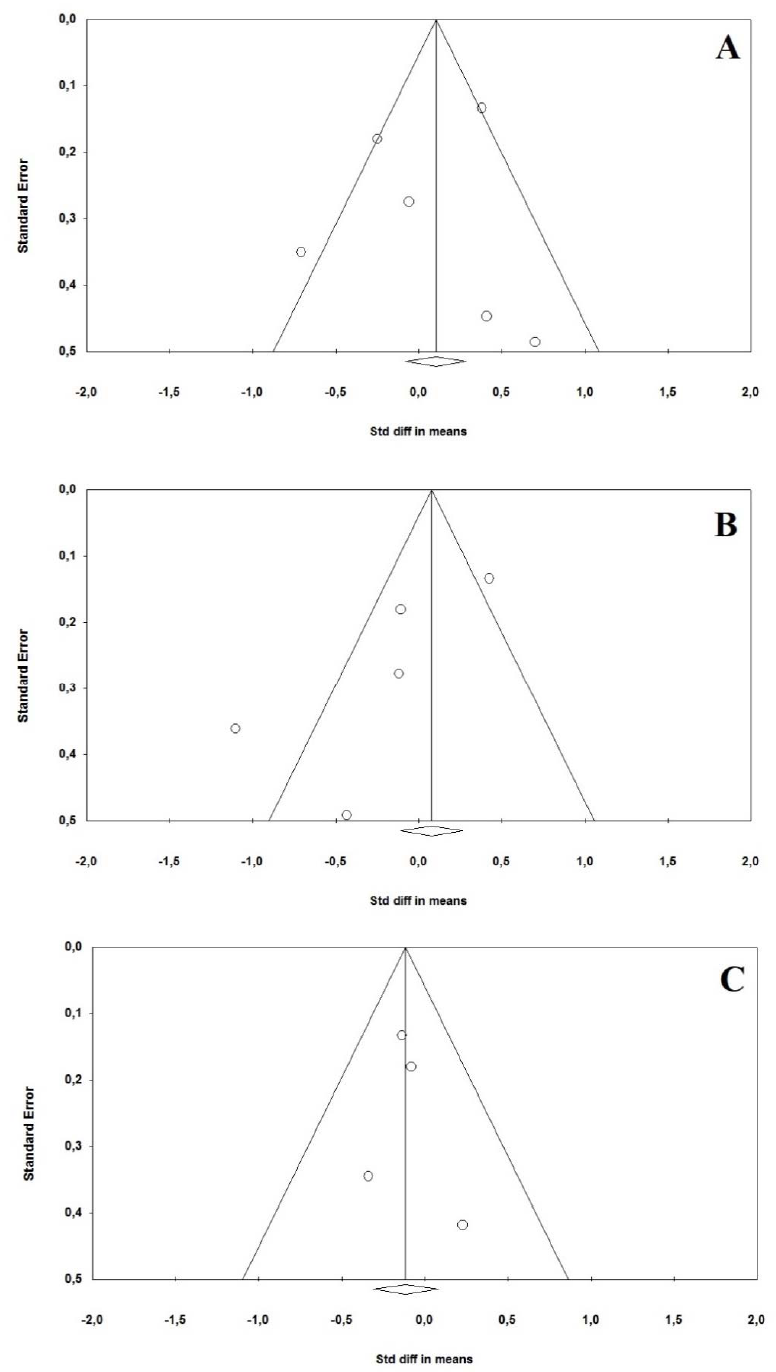
Figure 3. Funnel plots for the standardized mean difference (SMD) between asymptomatic and symptomatic SARS-CoV-2 patients for the RdRp (Panel A ), E (Panel B ) and N genes (Panel C ). Each study is represented by a circle. Diagonal lines represent the 95% confidence limits around the summary treatment effect, i.e., [summary effect estimate − (1.96 × standard error)] and [summary effect estimate + (1.96 × standard error)], for each standard error on the vertical axis. These show the expected distribution of studies in the absence of heterogeneity or of selection biases: in the absence of heterogeneity, 95% of the studies should lie within the funnel defined by these straight lines. As these lines are not strict 95% limits, they are referred to as “pseudo-95% confidence limits”. The rhomboid and relative vertical line represent the summary estimate of the treatment effect, derived using a random-effect meta-analysis